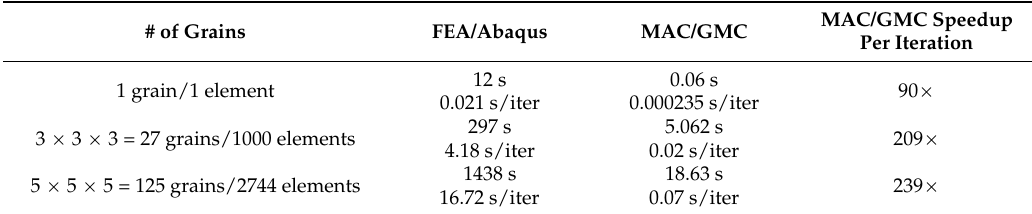
Table 4. Comparison of computational time between FEA and GMC